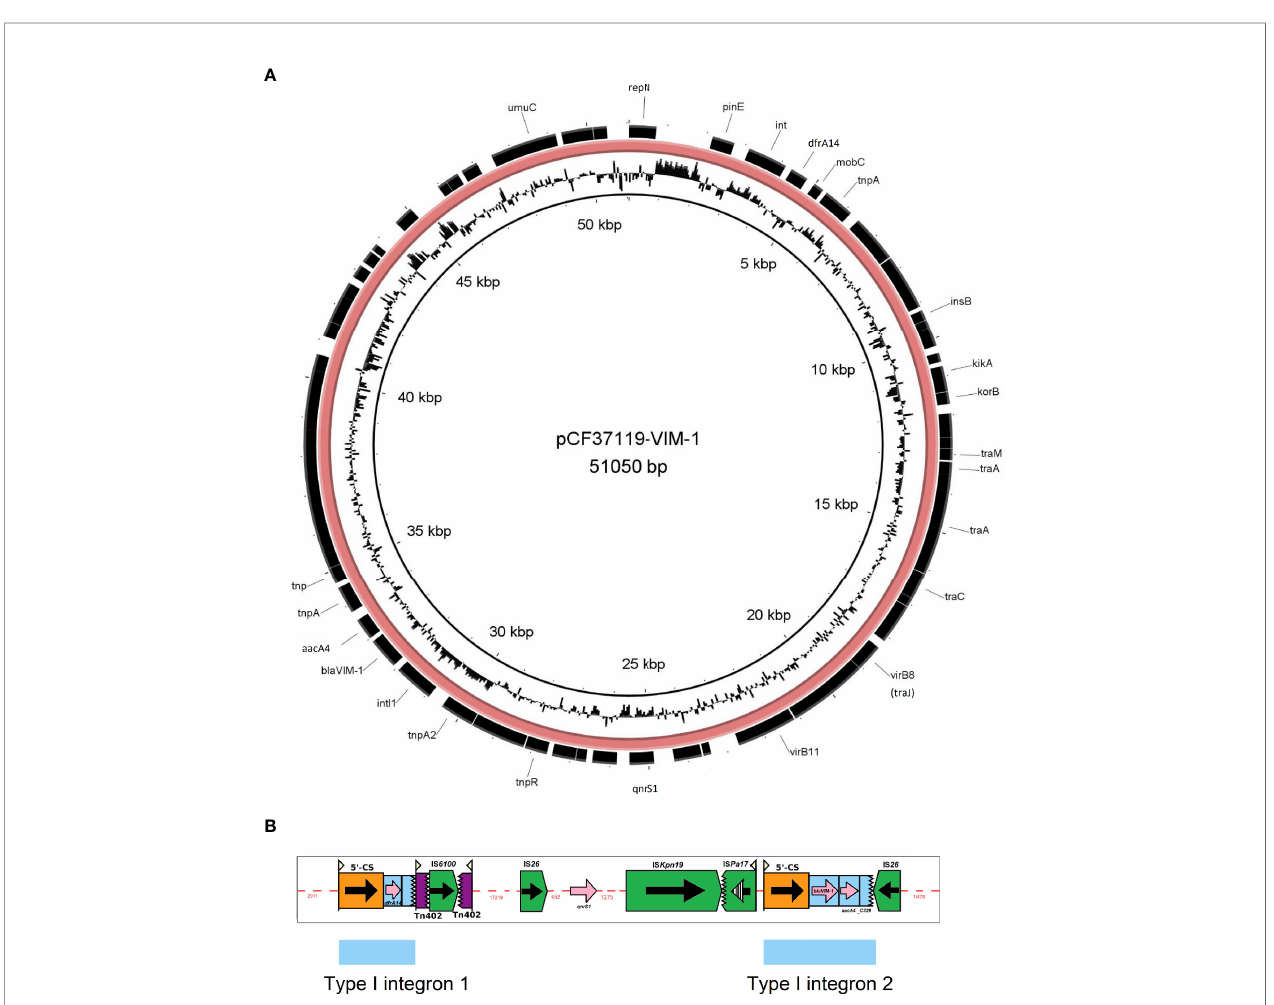
FIGURE 5 | Genetic map of the complete genome of the bla VIM-1 -encoding IncN[pMLST7] plasmid (A) and Depiction of insertion elements/transposons present in this plasmid (B) . The picture B was created using the Galileo AMR software (Partridge and Tsafnat,